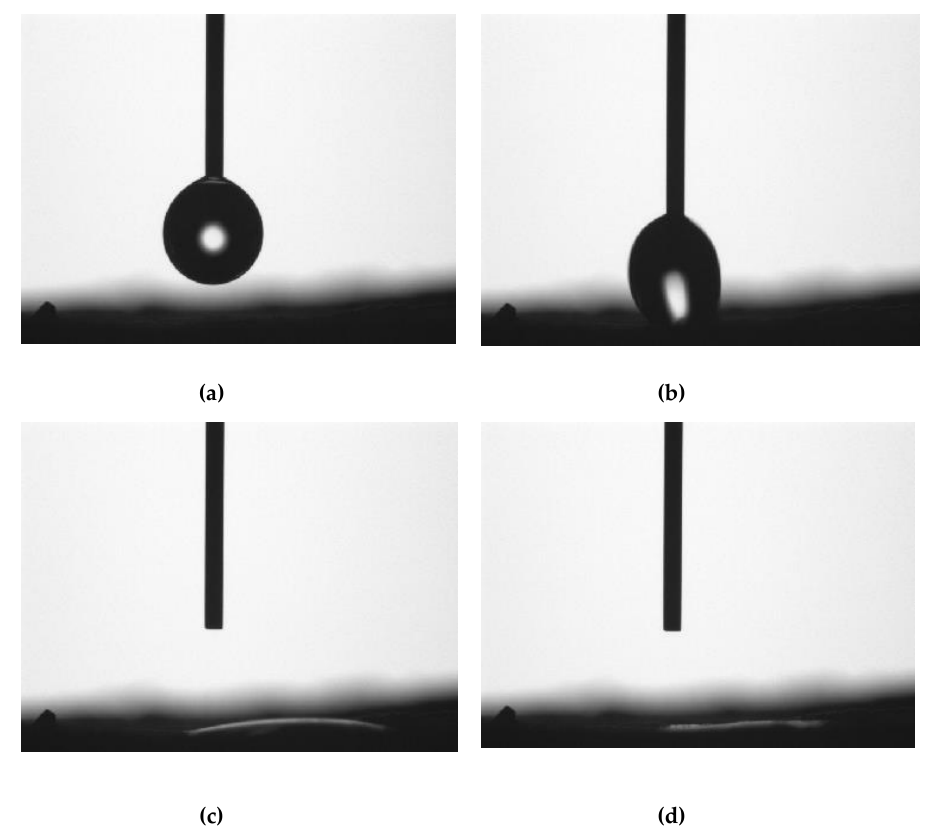
Figure 4. Consecutive video image frames [ a to d respectively] captured during tensiometer contact angle test demonstrates rapid water adsorption and indicating negligible hydrophobicity of the biochar sample .